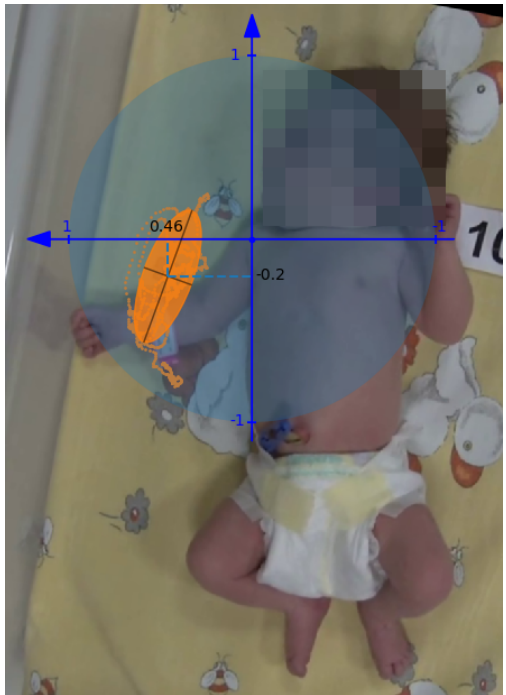
Figure 4. Visualization of the coordinate system associated with the right shoulder used to normalize the parameters of the ellipse circumscribed on the trajectory of the right wrist from a 30 s observation. The unit of the system is the length of the analyzed limb, whereas the sense of the horizontal axis is oriented towards the body axis. The blue circle shows the possible range of motion used to normalize the value of the area of the ellipse circumscribed on the trajectory (orange). Minor and major axes are marked inside the